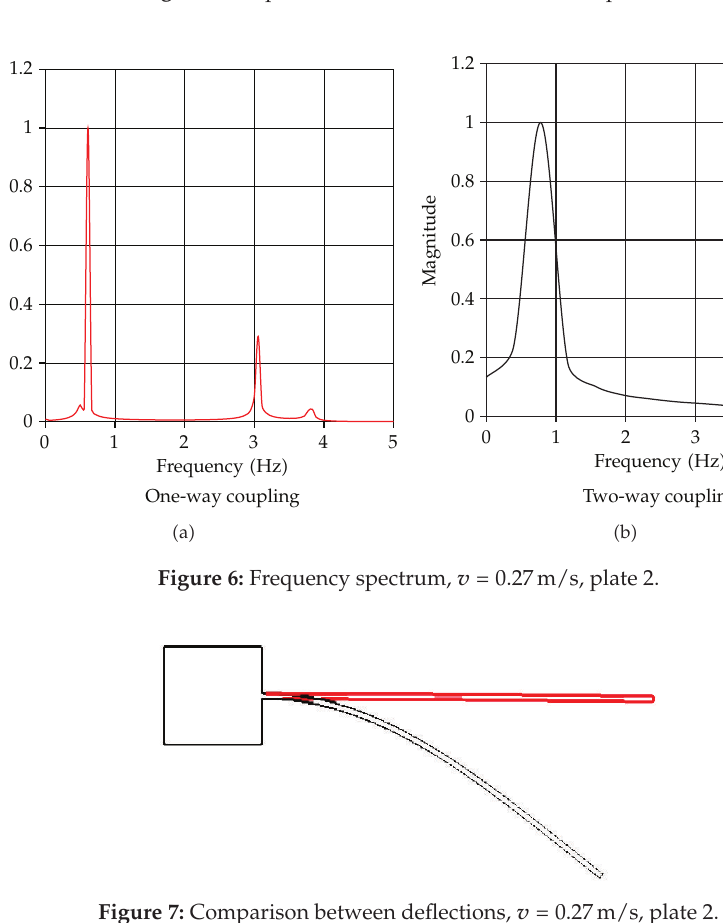
Figure 5: Displacement over time, v (cid:8) 0 . 27m/s, plate 2.